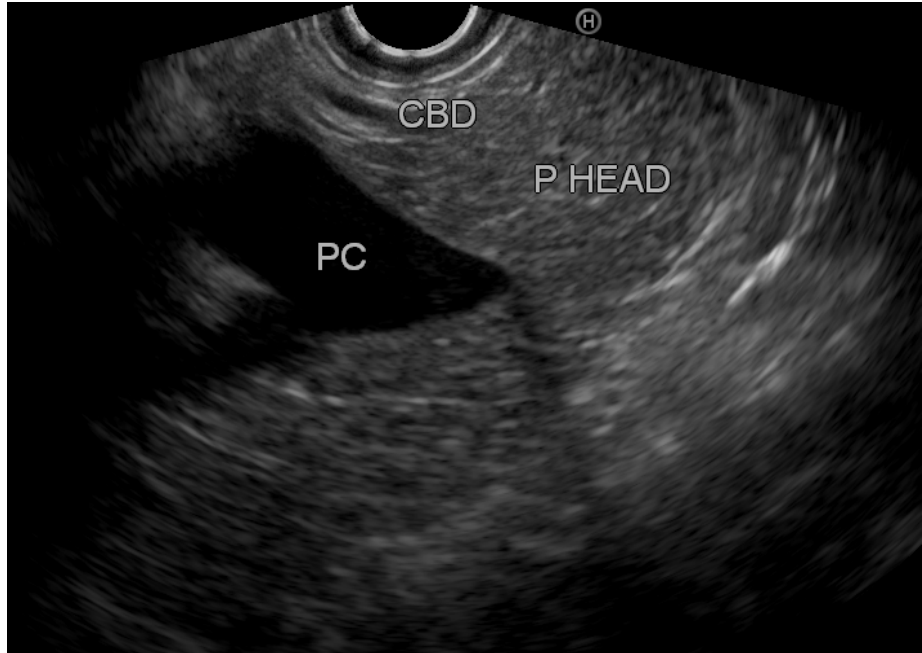
Figure 3. Normal pancreatic parenchyma. CBD: common bile duct; PC: portal confluence; P HEAD: pancreatic head.